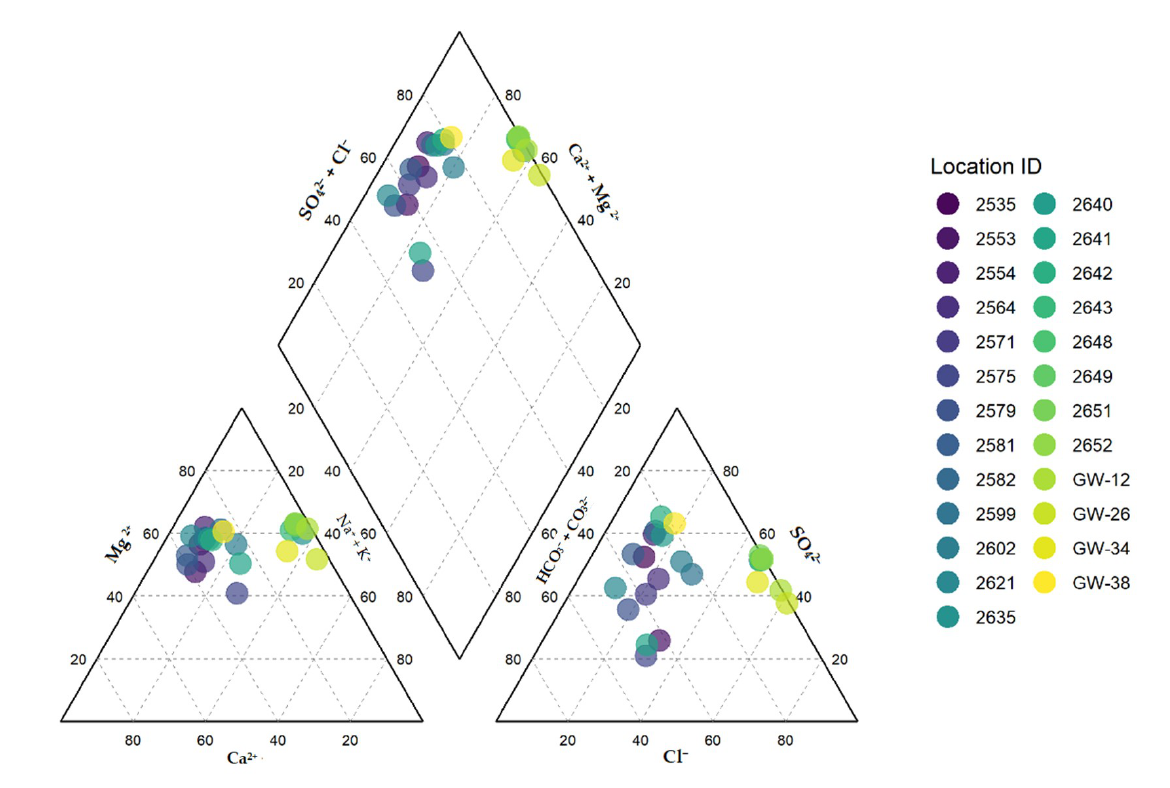
Figure 3. Piper diagram showing the chemical composition of the water samples during the studied